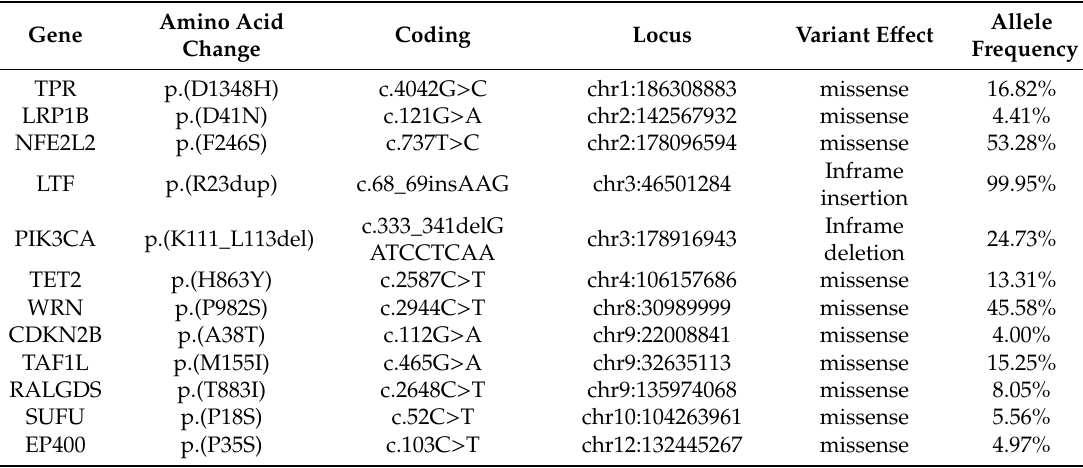
Table 2. Mutational signatures of the patient with primary signet ring cell / histiocytoid carcinoma of the eyelid.